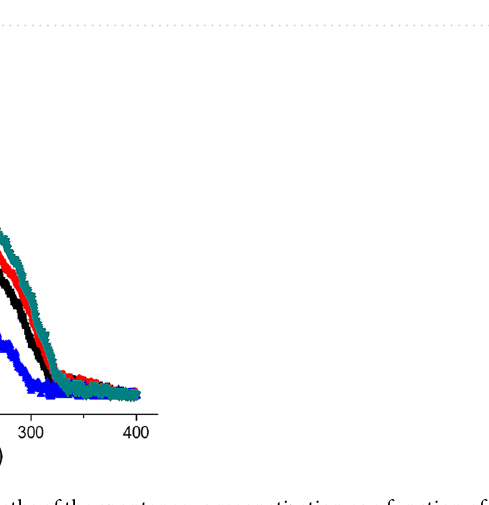
Figure 3. Some examples of different paths of the spontaneous magnetization as a function of temperature. Paths were obtained in cooling processes from different initial random states keeping the same number of